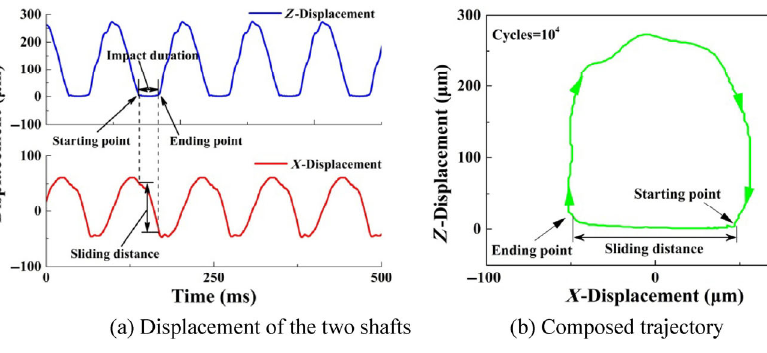
Fig. 7 Real displacement of the two directions and composed trajectory under unidirectional motion.